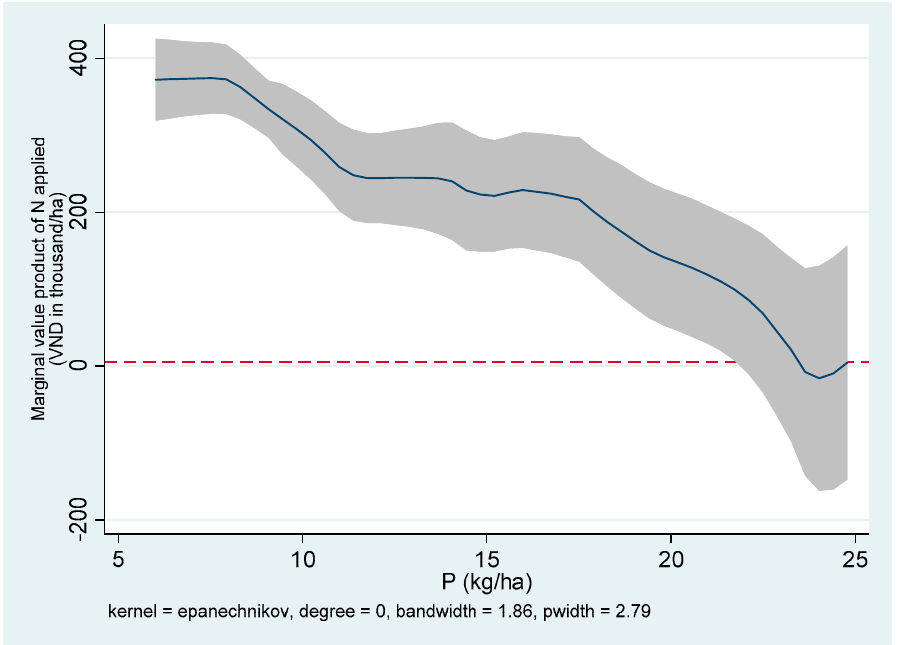
Figure 9. Marginal value product of N and P applied in Ha Noi, Vietnam.